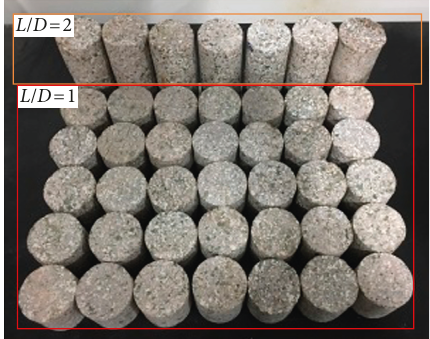
Figure 1: Part of the typical